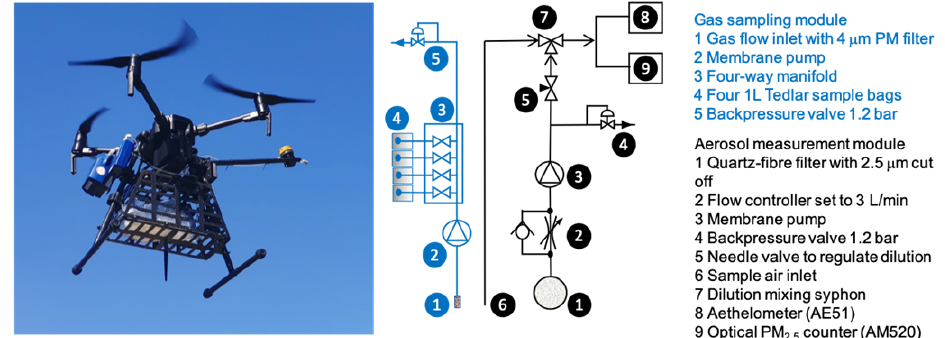
Figure 1. Photo and schematic representation of the gas sampling system (blue) and aerosol measurement system (black) as installed on the DJI Matrice 200